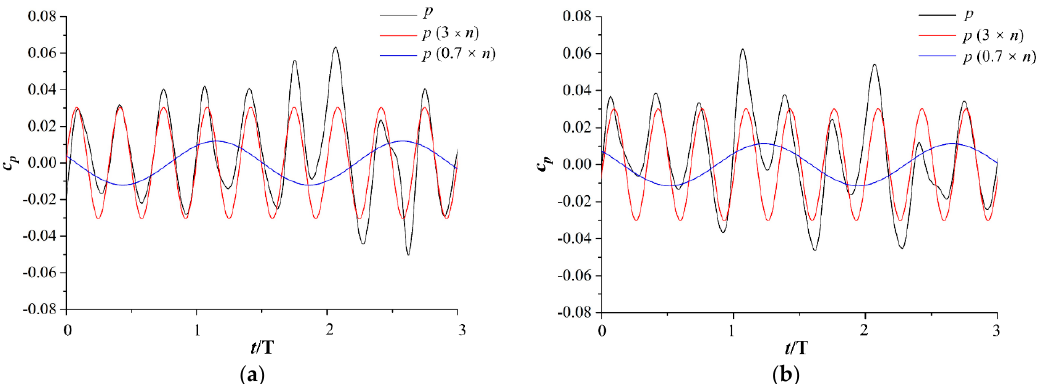
Figure 13. Time history of pressure signal and pressure components of frequencies as 3 × n and 0.7 × n at 0.5 × Q 0 operating condition. ( a ) Monitor point P11; and ( b ) monitor Point S13.